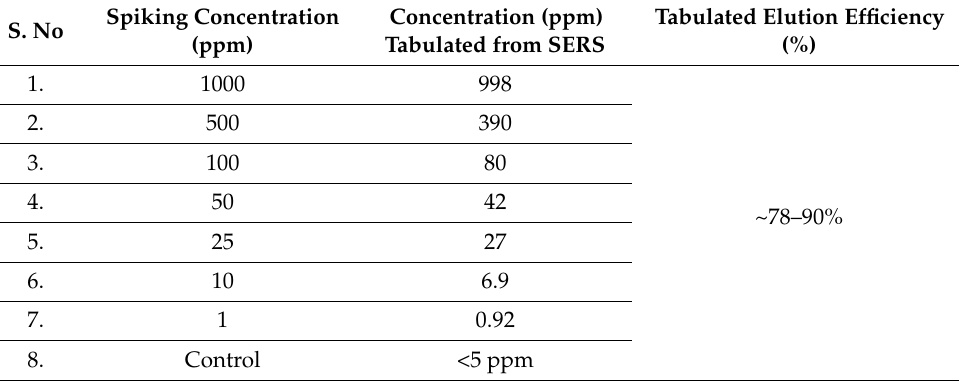
Table 1. DA concentrations tabulated for the eluted samples from the SERS calibration curve. S.